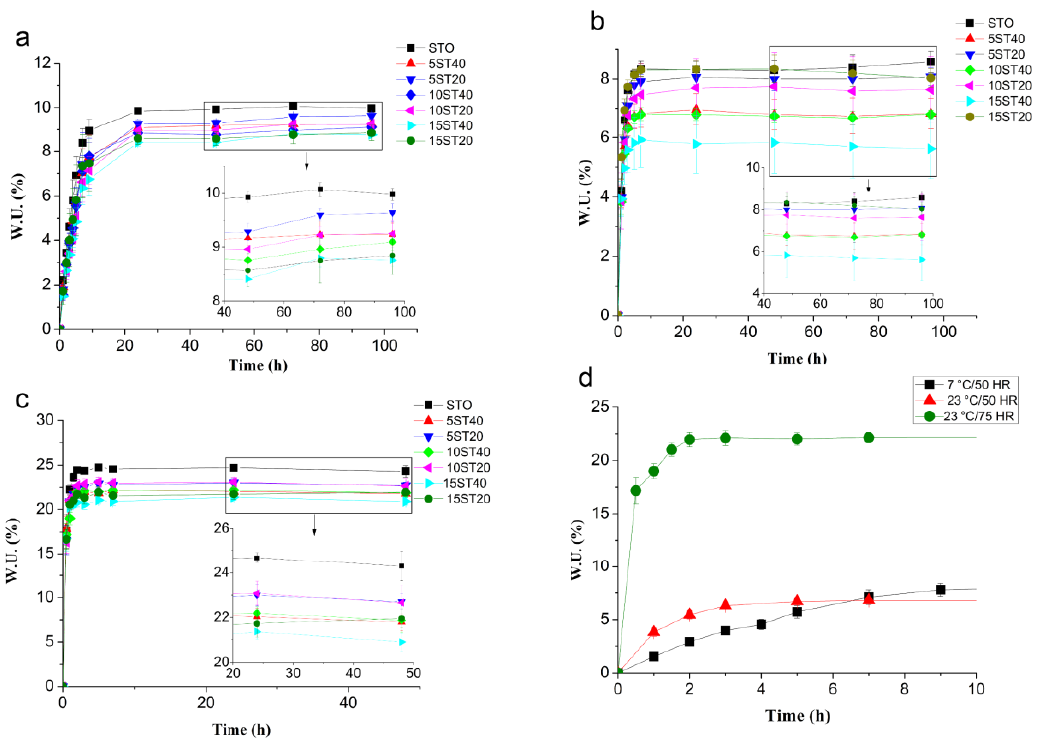
Figure 3. Water uptake profiles of starch composite films reinforced with CNF BEP . Conditions: ( a ) 7 ◦ C / 50% relative humidity (RH), ( b ) 23 ◦ C / 50% RH, and ( c ) 23 ◦ C / 75% RH. ( d ) Comparative water uptake profile of formulation 10ST40 under di ff erent conditions. W.U., water